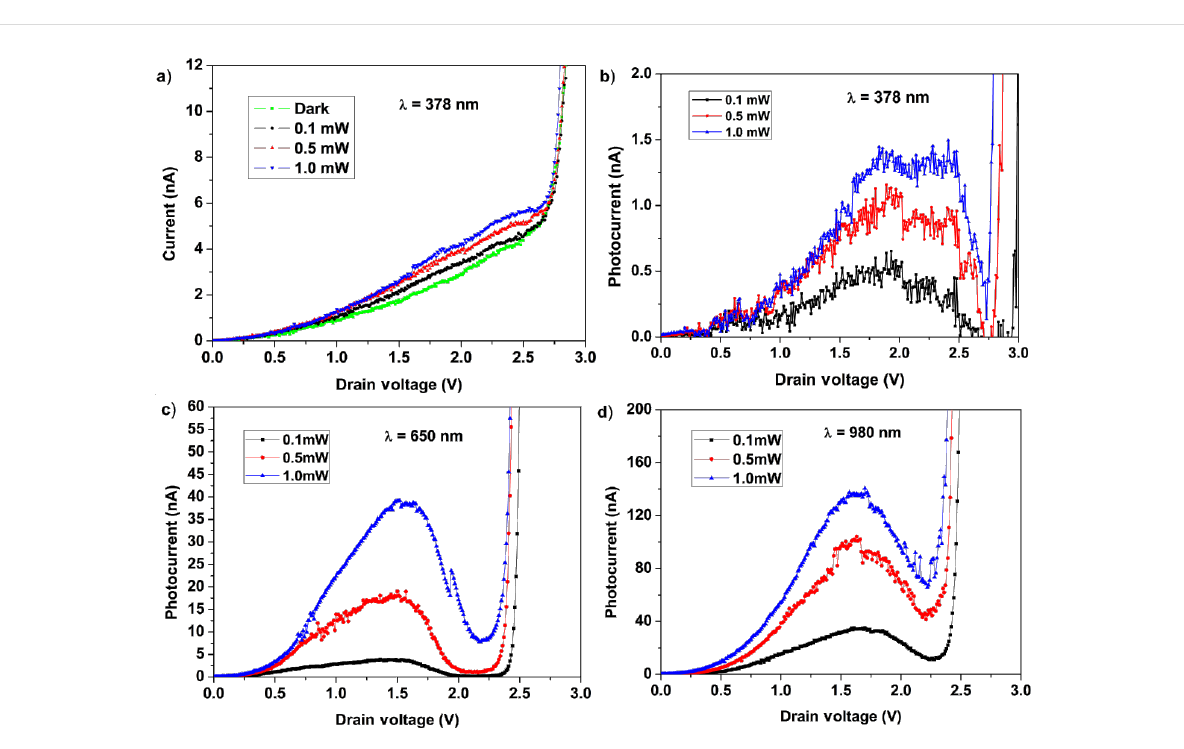
Figure 6: (a) Dark current and photocurrent tunneling in a CNT–Si heterojunction under 378 nm light illumination at different intensities. (b) The same as in (a) after subtracting the dark current. (c) The same as in (b) but for 650 nm and (d) 980